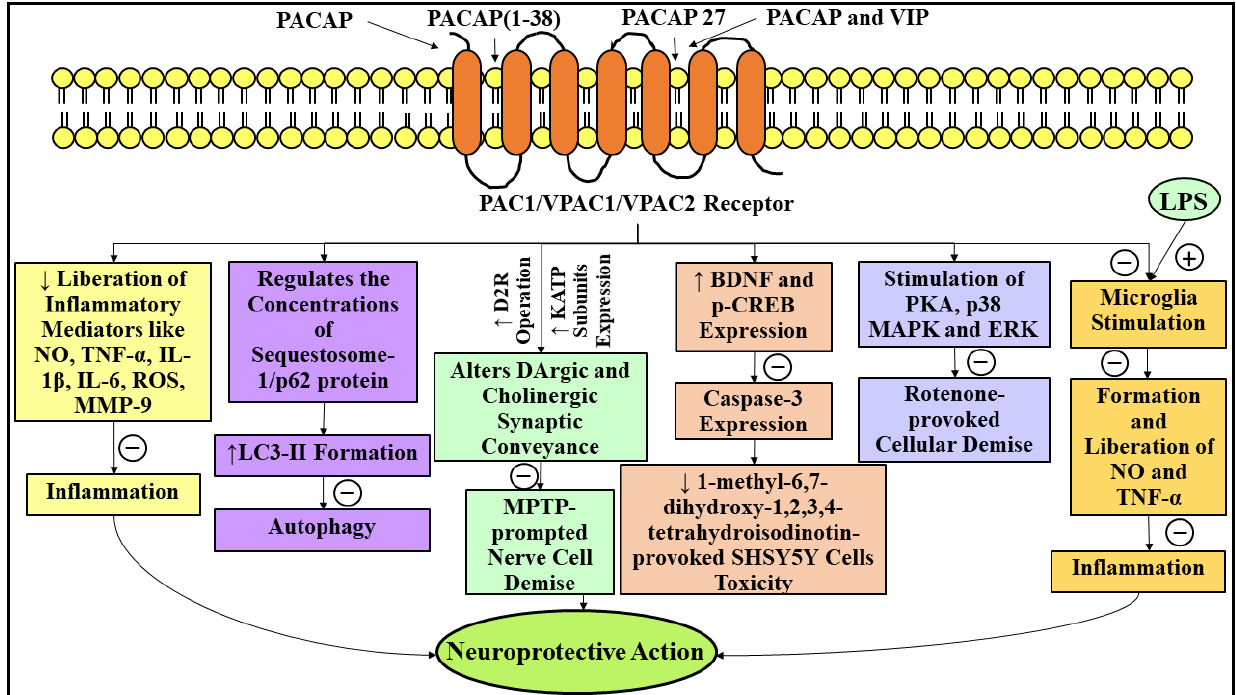
Figure 7. Highlighting the neuroprotective role of pituitary adenylate cyclase-activating polypeptide in Parkinson’s disease. The duo, namely experimental animal and cellular PD models illustrate that PACAP therapy renders significant nerve cell protective action against rotenone, MPTP, and 1-methyl-6,7-dihydroxy-1,2,3,4-tetrahydroisochinolin-provoked deleterious repercussions through suppressing inflammation, autophagy, and cellular demise. The prior therapy of SH-SY5Y cells with PACAP (1–38) safeguarded these cells against inflammatory-mediated detrimental effects via decreasing the liberation of inflammatory mediators. PACAP regulates the sequestosome-1/p62 protein concentrations and elevates the LC3-II formation, and thereby suppresses the autophagic-operation. PACAP safeguarded against rotenone-precipitated cellular demise via carrying out the stimulation of PKA signaling process, as well as the two downstream signals, viz., p38 MAPK and ERK. In addition, intravenously introduced PACAP27 safeguarded against MPTP-instigated nerve cell demise via altering the DArgic and cholinergic synaptic conveyance, by way of elevating the D2R operation and the KATP subunits expression within the striatal region of the basal nuclei. Further, therapy with the assistance of PACAP/agonists of PACAP receptors elevated the BDNF and p-CREB expression, and suppressed the caspase-3 expression, and, as a consequence, decreased the 1-methyl-6,7-dihydroxy-1,2,3,4-tetrahydroisochinolin-prompted SH-SY5Y cells toxicity. Apart from this, PACAP has the tendency to considerably suppress the LPS-prompted microglia stimulation, which in turn suppresses the formation and liberation of NO and TNF- α , and finally suppresses the inflammation. Subtraction symbol indicates inhibitory/suppressing action, while addition symbol indicates stimulatory action. PACAP, pituitary adenylate cyclase-activating polypeptide; VIP, vasoactive intestinal polypeptide; PAC1, PACAP type I receptor; VPAC1, VIP receptor 1; VPAC2,